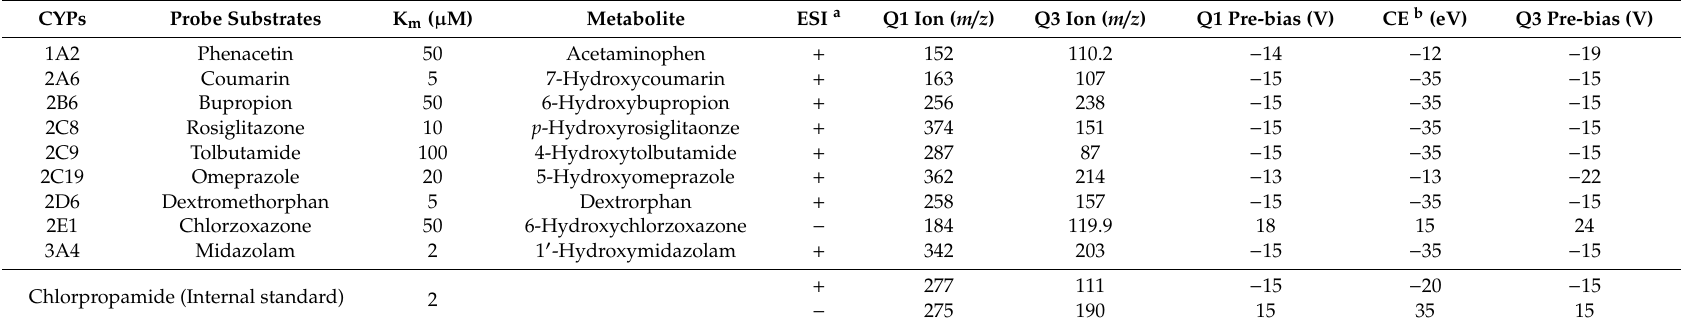
Table 1. Optimized mass parameters for the detection of metabolites of the nine P450-probe substrates and internal standard used in the cocktail assays.